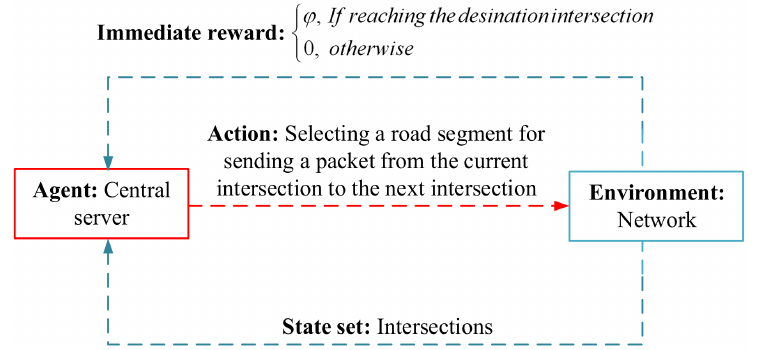
Figure 9. Learning structure in